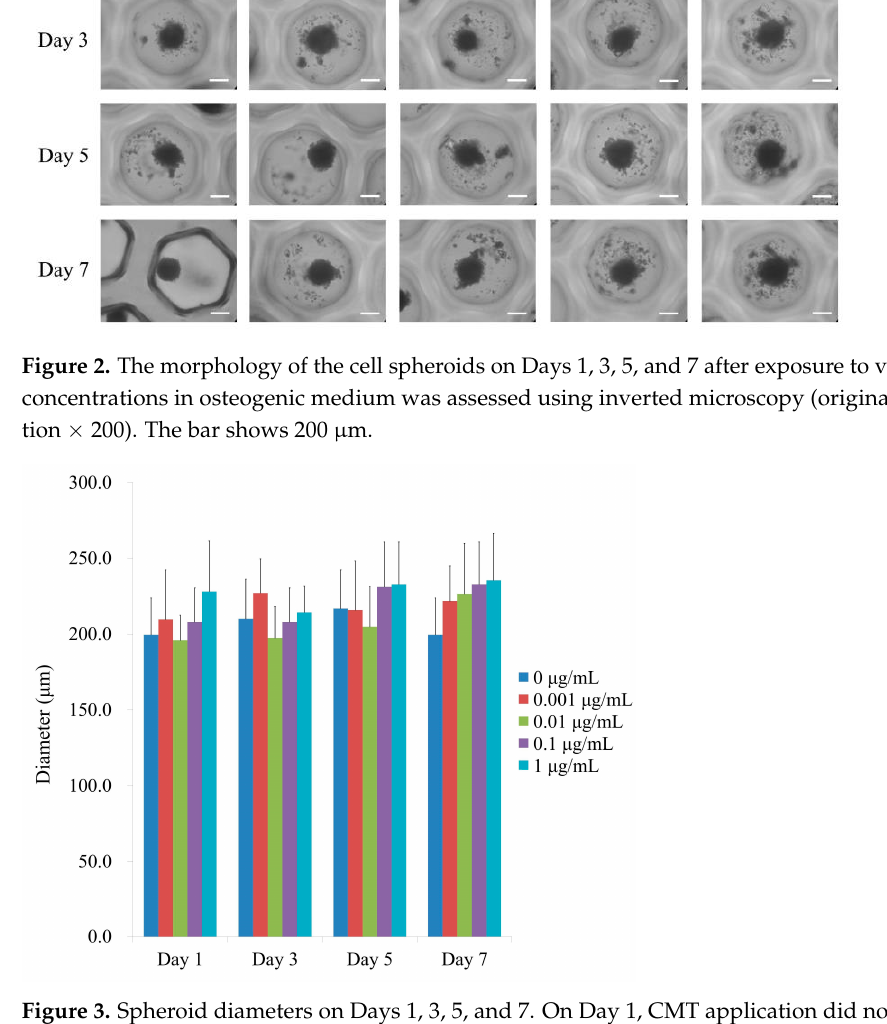
Figure 3. Spheroid diameters on Days 1, 3, 5, and 7. On Day 1, CMT application did not reveal any statistically significant differences ( p > 0.05). Additionally, no statistically significant alterations were detected between the groups in the longer culture period ( p > 0.05).